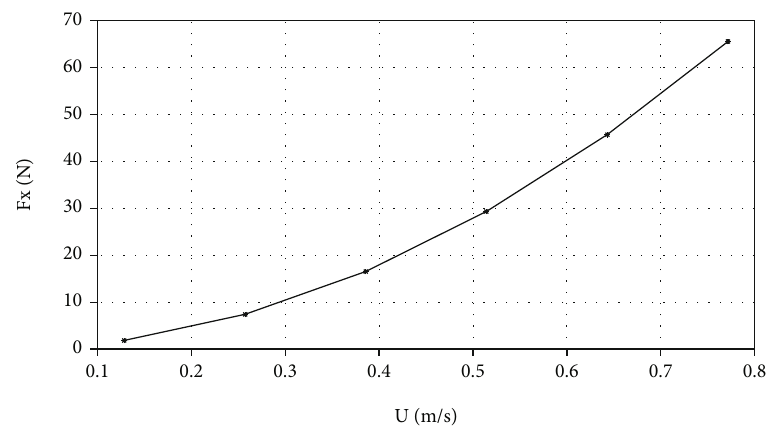
Figure 9: Relationship between the drag force and velocity.